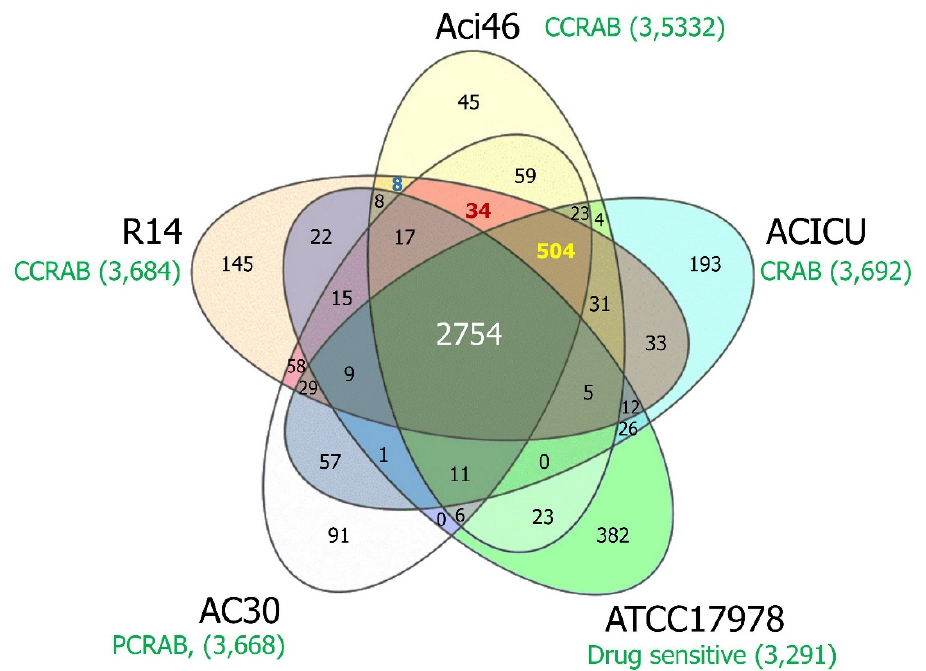
Figure 3. Venn diagram of comparative pangenome analysis among A. baumannii strains. The yellow, blue, green, white, and orange represent Aci46, ACICU, ATCC17978, AC30, and R14, respectively, with the number of total genes and the character of drug resistance in each genome (shown in green). The overlapped areas show genes encoding shared protein families among strains. The number of genes in core genes (Aci46, ACICU, ATCC17978, AC30, and R14), MDR (Aci46, ACICU, AC30, and R14), PCRAB (Aci46, AC30, and R14), and CCRAB (Aci46 and R14) the specific groups are labeled in white, yellow, red, and blue, respectively. CRAB: carbapenem-resistant A. baumannii , CCRAB: colistin and carbapenem-resistant A. baumannii , PCRAB: polymyxins and carbapenem-re- sistant A. baumannii .